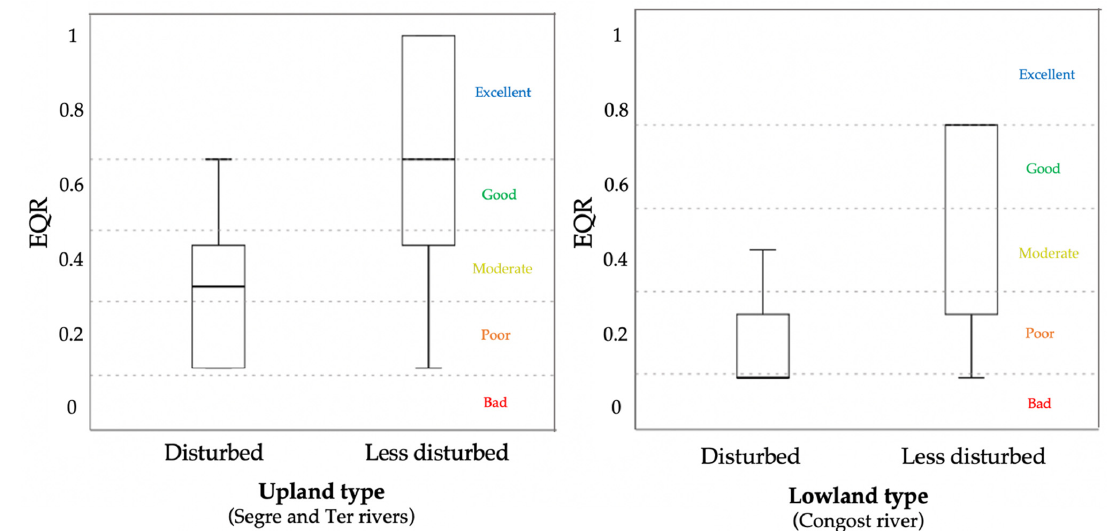
Forests 2021 , 12 , 625 Figure 4. Boundary values for the five classes of ecological quality of the Ant-based MMI expressed in Ecological Quality Ratios (EQR) for the Lowland and Upland river types. Boxes show interquartile ranges (25th and 75th percentiles), middle lines are medians, and whiskers are non-outlier ranges beyond the boxes. Table 4. Summary table of agreement between Ant-based MMI and the QBR index for the assess- ment of riparian quality.